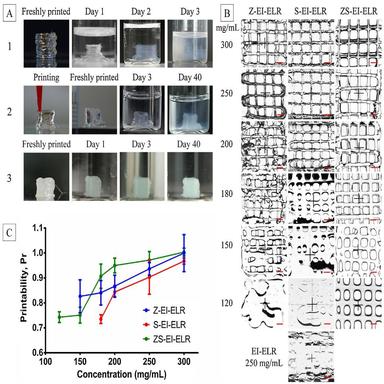
(A) Pictures of structures printed using 1) Z-EI-ELR, 2) S-EI-ELR, and 3) ZS-EI-ELR, showing the stability over time. (B) Images of the printed Z-EI-ELR, S-EI-ELR, and ZS-EI-ELR structures at concentrations of 120, 150, 180, 200, 250 and 300 mg/mL, and EI-ELR at 250 mg/mL, all of them in PBS. Scale bar: 1 mm. (C) Calculated Pr values for the printed Z-EI-ELR, S-EI-ELR, and ZS-EI-ELR structures at concentrations of 120, 150, 180, 200, 250 and 300 mg/mL in PBS.